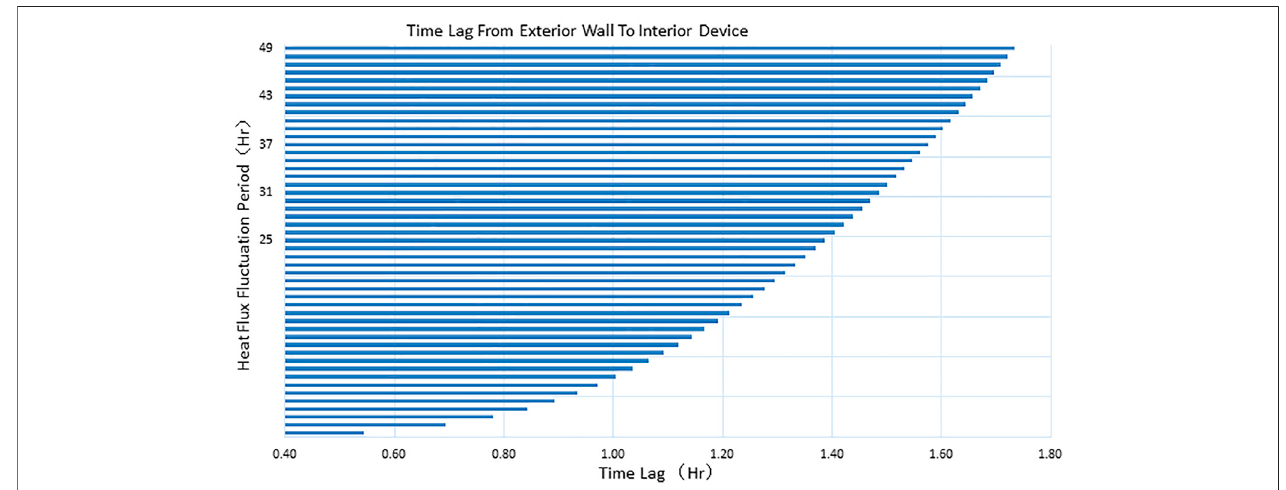
FIGURE 6 | Time lag from exterior wall to interior device of different heat fl ux fl uctuation.